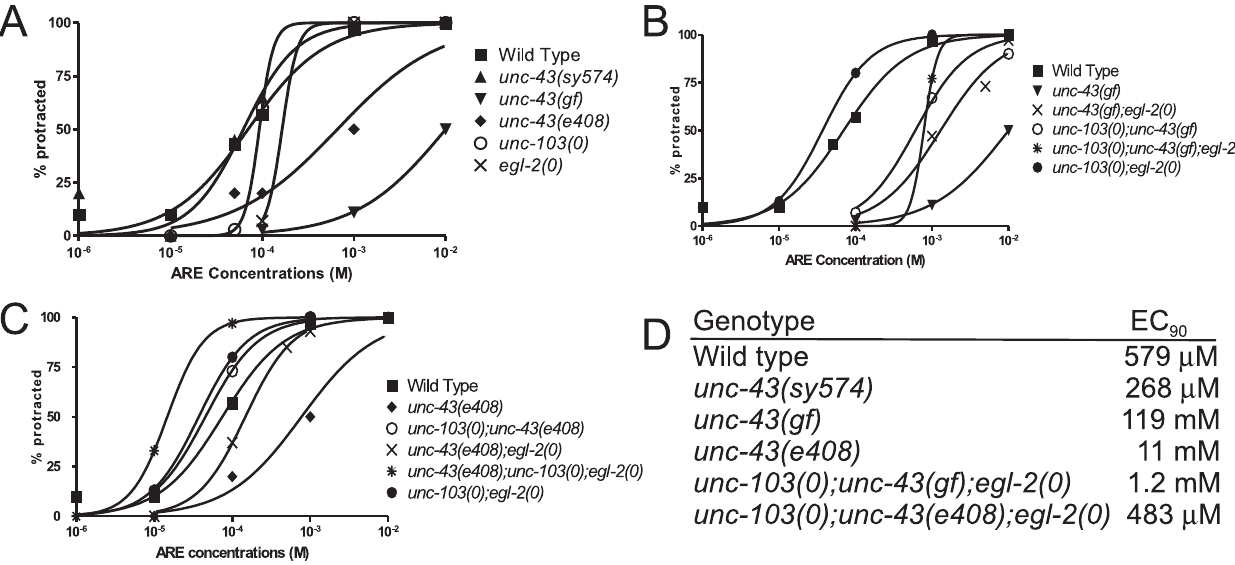
Figure 2. ARE Pharmacology of unc-43 Mutants (A–C) Graphs of male muscle ARE sensitivity. The ARE concentrations are indicated on the x -axis, and the percent of males protracting their spicules in the drug are indicated on the y -axis. For each data point, n ¼ 30 males. (D) EC 90 values at which 90% of males protracted their spicules for the genotypes listed.